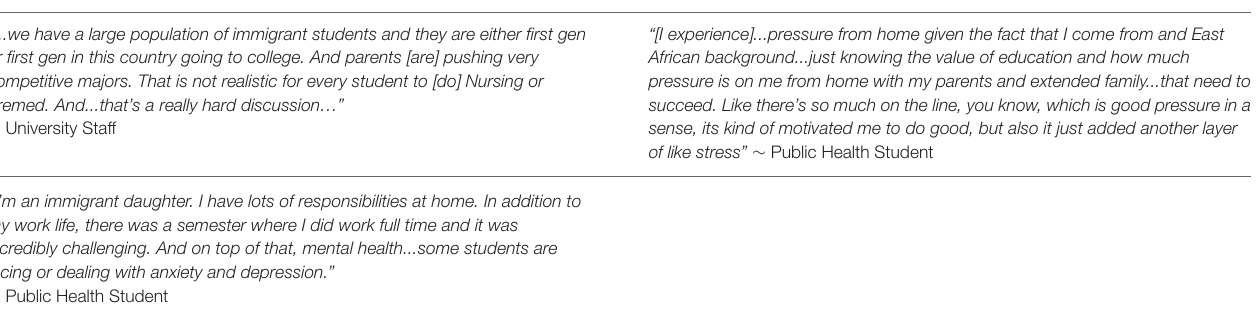
TABLE 5 | Family expectations: illustrative comments from study participants.